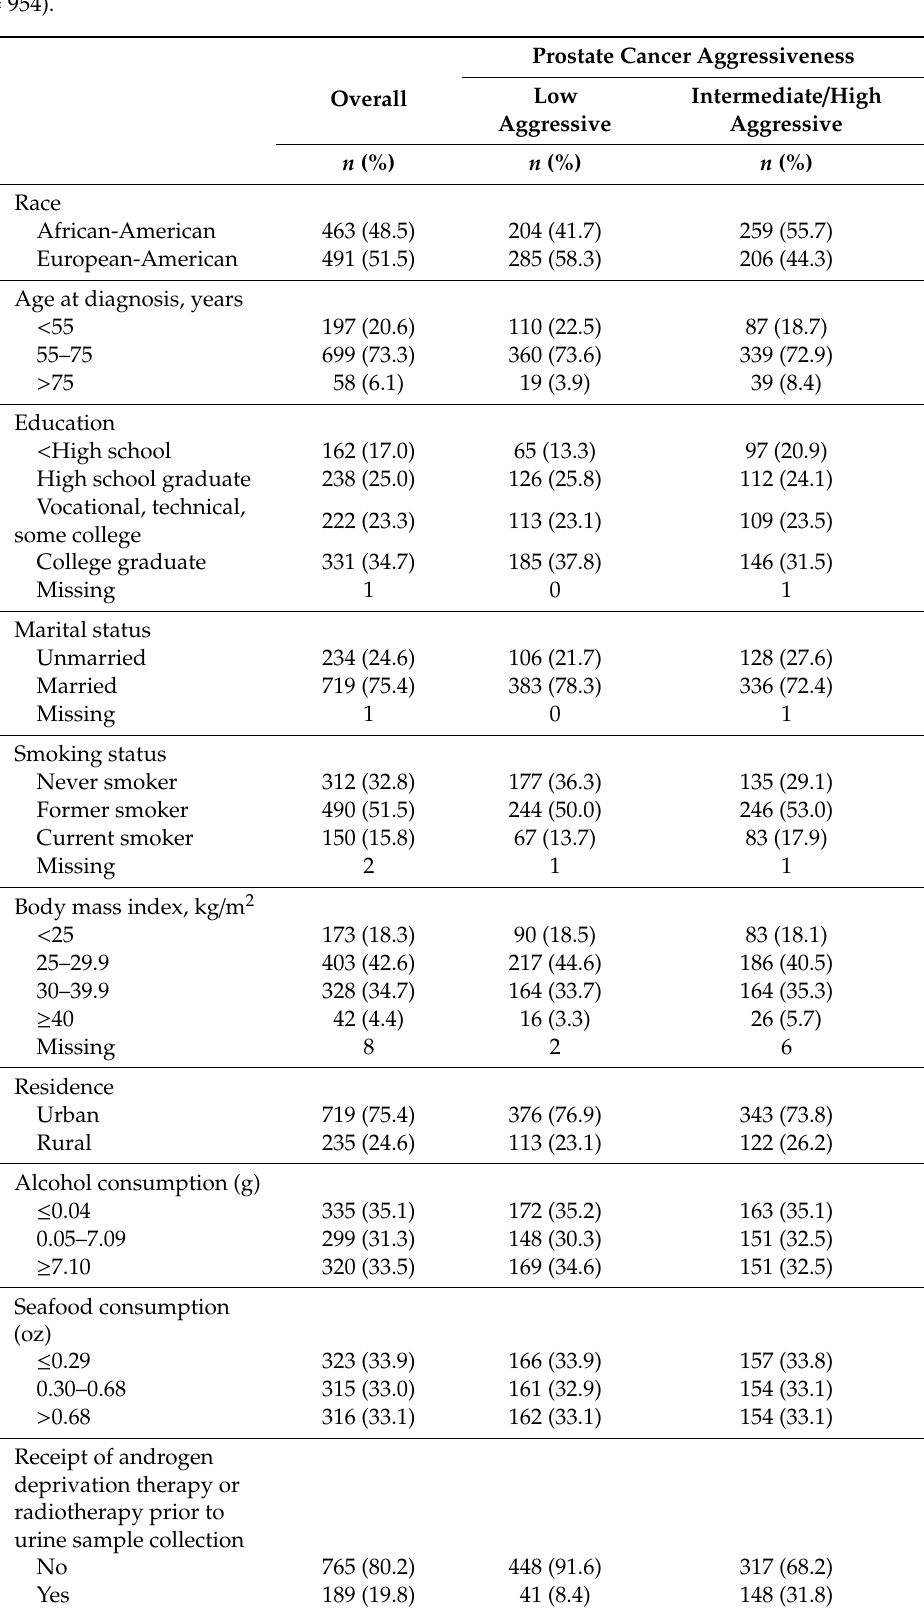
Table 1. Distribution of select characteristics among the Prostate Cancer Project (PCaP) men with available estimates of urinary arsenic overall and by quantiles of specific gravity-adjusted total arsenic ( n =